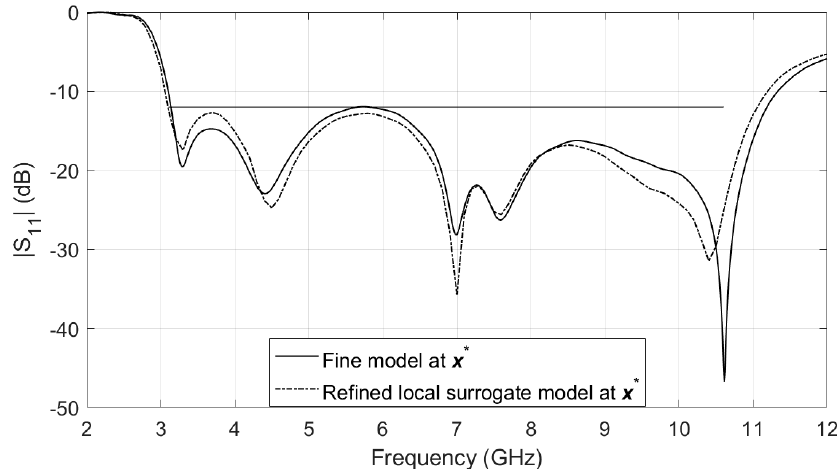
Figure 6. A UWB monopole antenna: response of the optimal design in the refined local surrogate model and in the fine model.